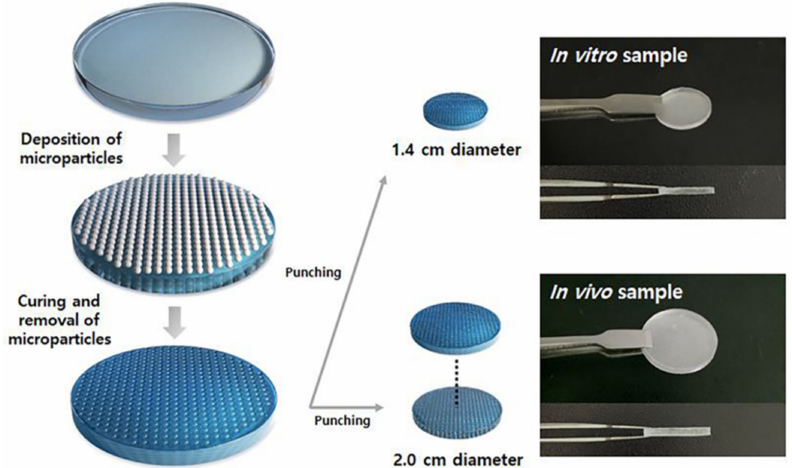
Figure 15. Preparation of the concave hemisphere pattern on the PDMS surface